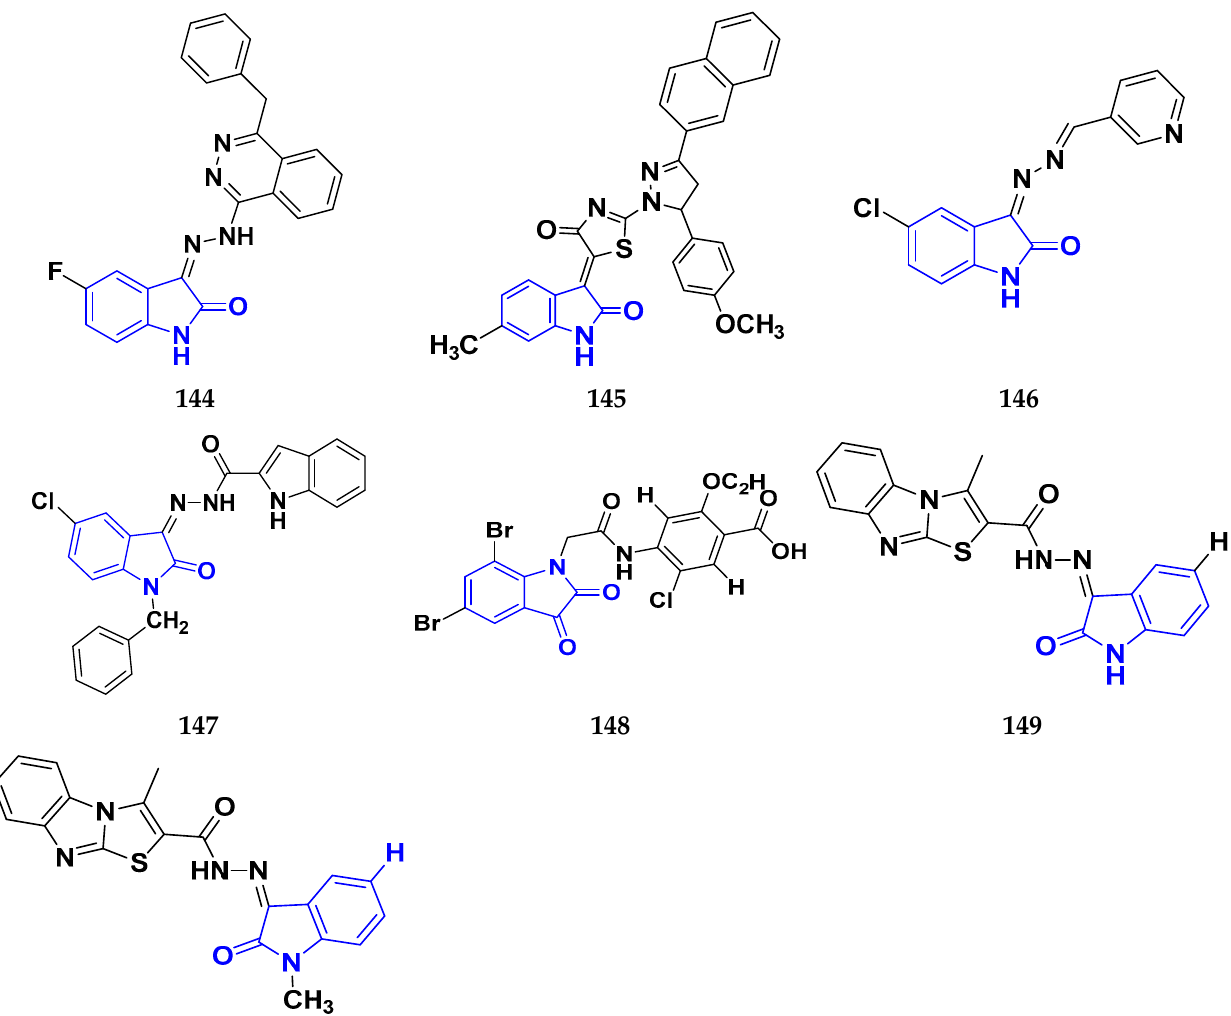
Figure 15. Isatin derivatives ( 144 – 150 ) as anticancer agents.